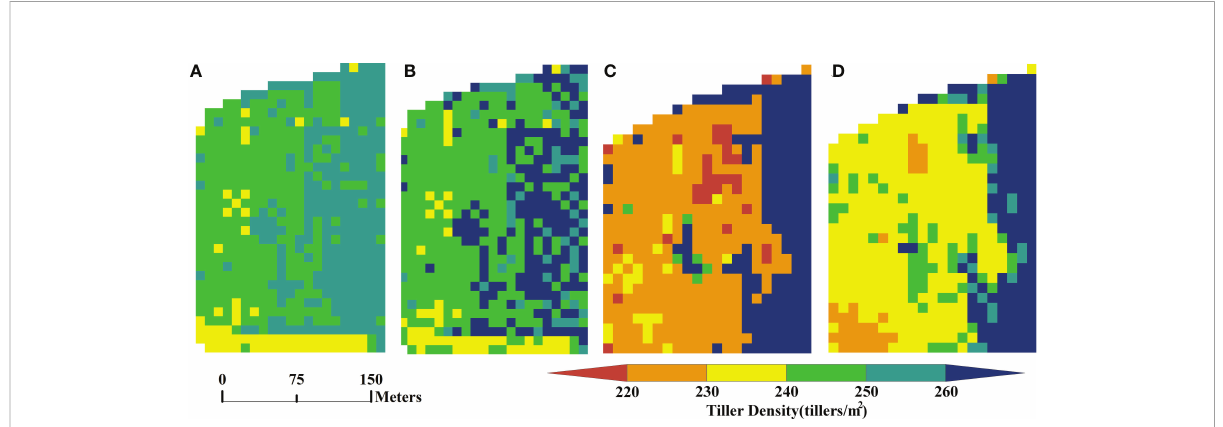
FIGURE 2 Spatial distribution of tiller density estimated using hyperspectral and multispectral data: (A) results for RF model applied to hyperspectral data, (B) results for GBRT model applied to hyperspectral data, (C) results for RF model applied to multispectral data, and (D) results for GBRT model applied to multispectral